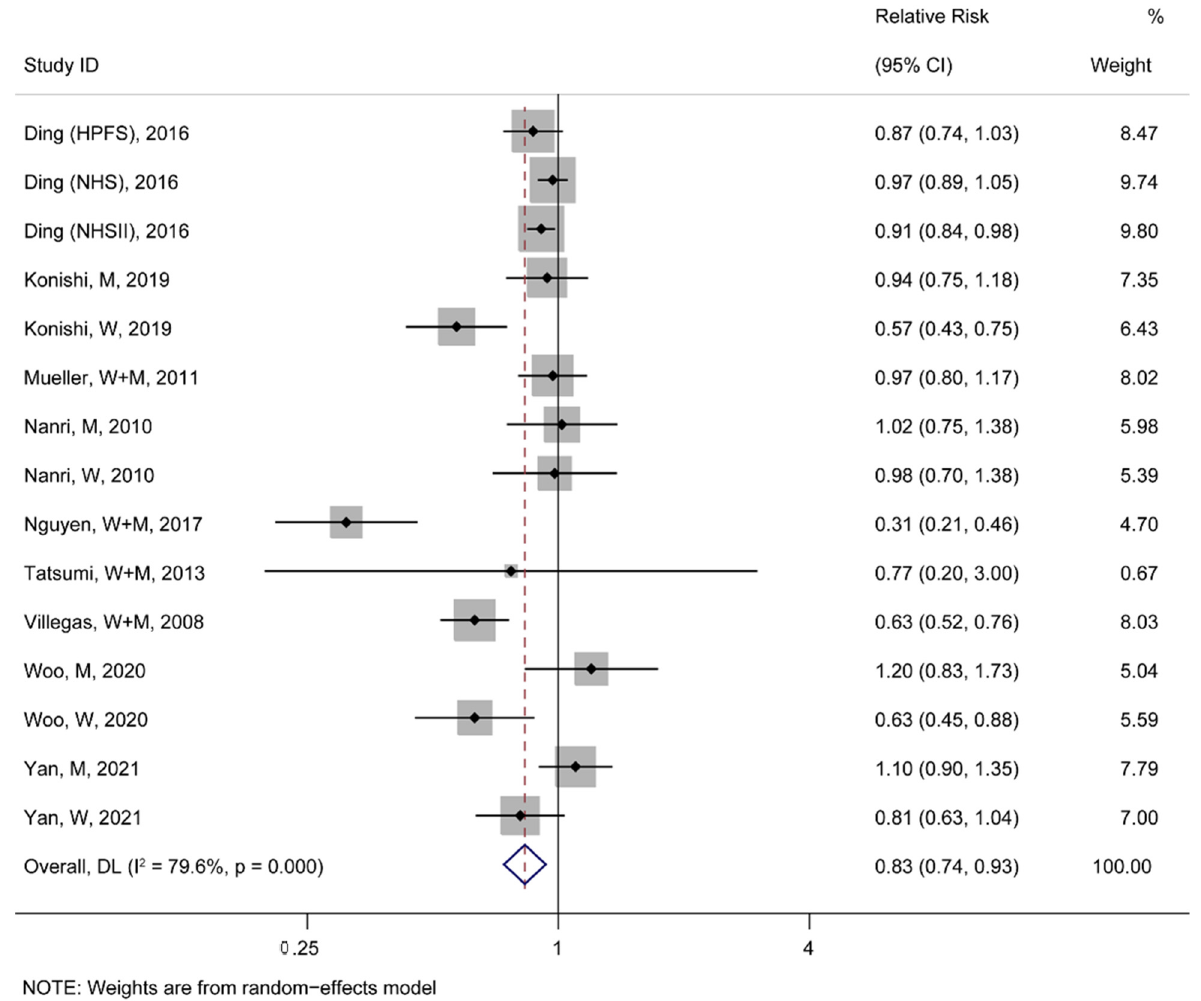
Figure 2. The pooled risk association of T2D with soy consumption [30–38]. In the forest plot, the black point represents the point estimate of the effect size of each study, the gray square means the weight of each study, the line length represents the 95% confidence interval (CI) of the effect size of each study, the diamond represents the meta-analysis synthesizes the summary results of each study, the diamond center represents the point estimate of the effect size of the summary results, and the diamond width represents the 95% CI of the effect size of the summary results.